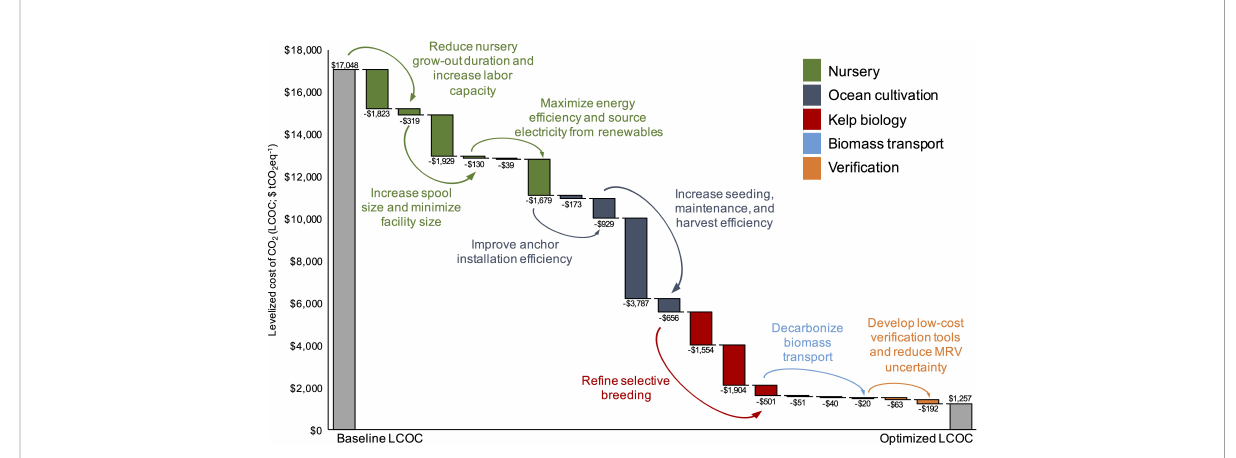
FIGURE 7 Optimization analysis in which the values for 18 key parameters were sequentially changed to either the minimum or maximum value identi fi ed in literature reviews that improved (lowered) levelized sequestration costs ($ tCO 2 eq -1 ). The changes were then combined to calculate an “ optimized ” LCOC as a result of process improvement and cost reductions ( gray column ). Colors correspond to the 5 areas of potential improvements: nursery production ( green ), ocean cultivation ( dark blue ), kelp biology ( red ), biomass transport ( light blue ), and veri fi cation ( orange